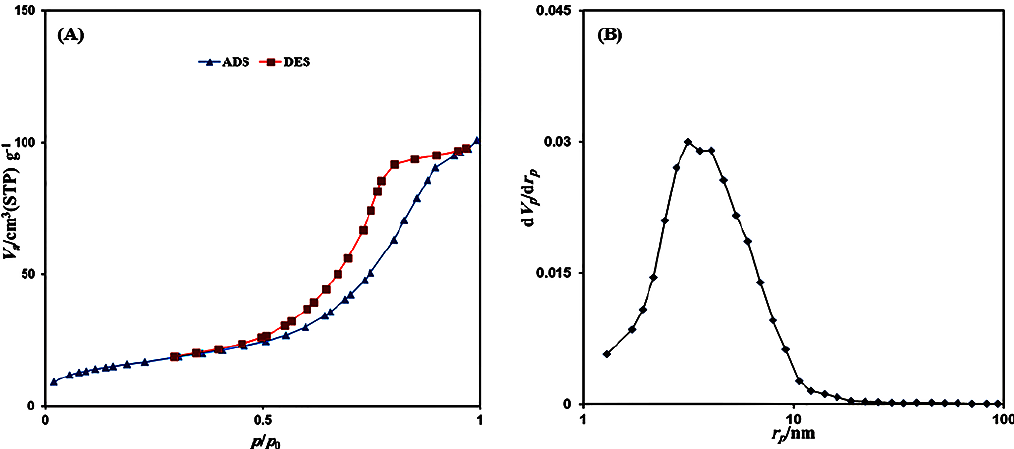
Figure 5. N 2 adsorption–desorption isotherms ( A ) and pore size distribution ( B ) of the synthesized nanoplatform in optimal conditions.